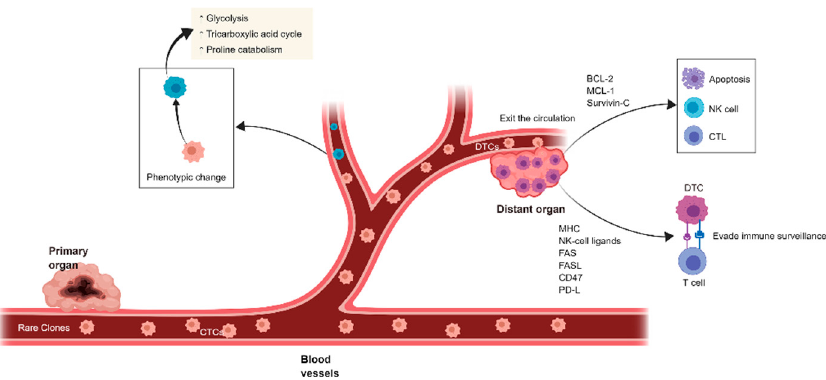
Figure 1. Cancer metastatic cascade involving CTCs and DTCs . Tumor cell dissemination